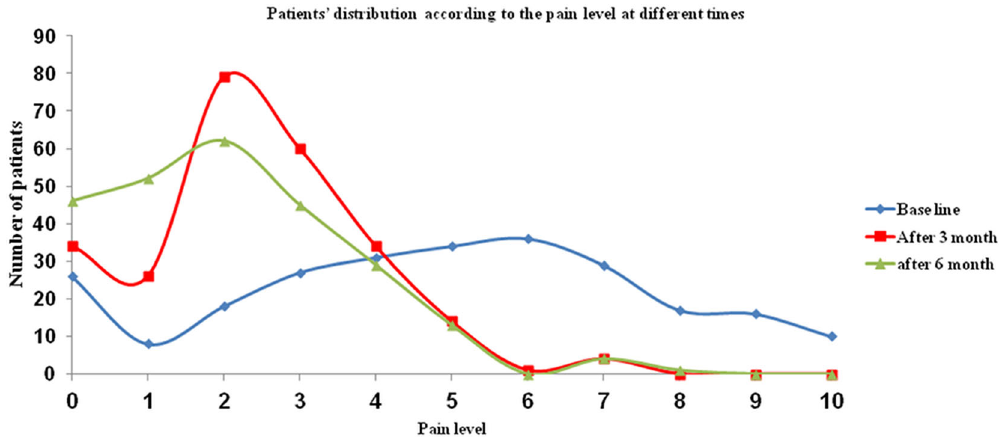
Figure 4. Patients ’ distribution according to the referred pain levels at different times after